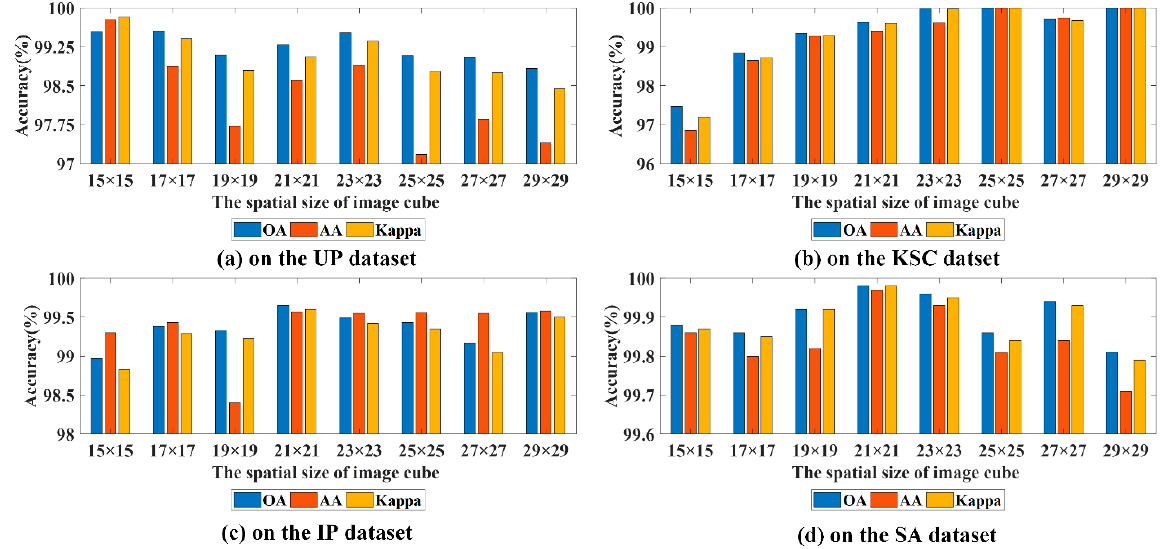
Figure 5. Three evaluation indexes for different spatial sizes on four experimental datasets.